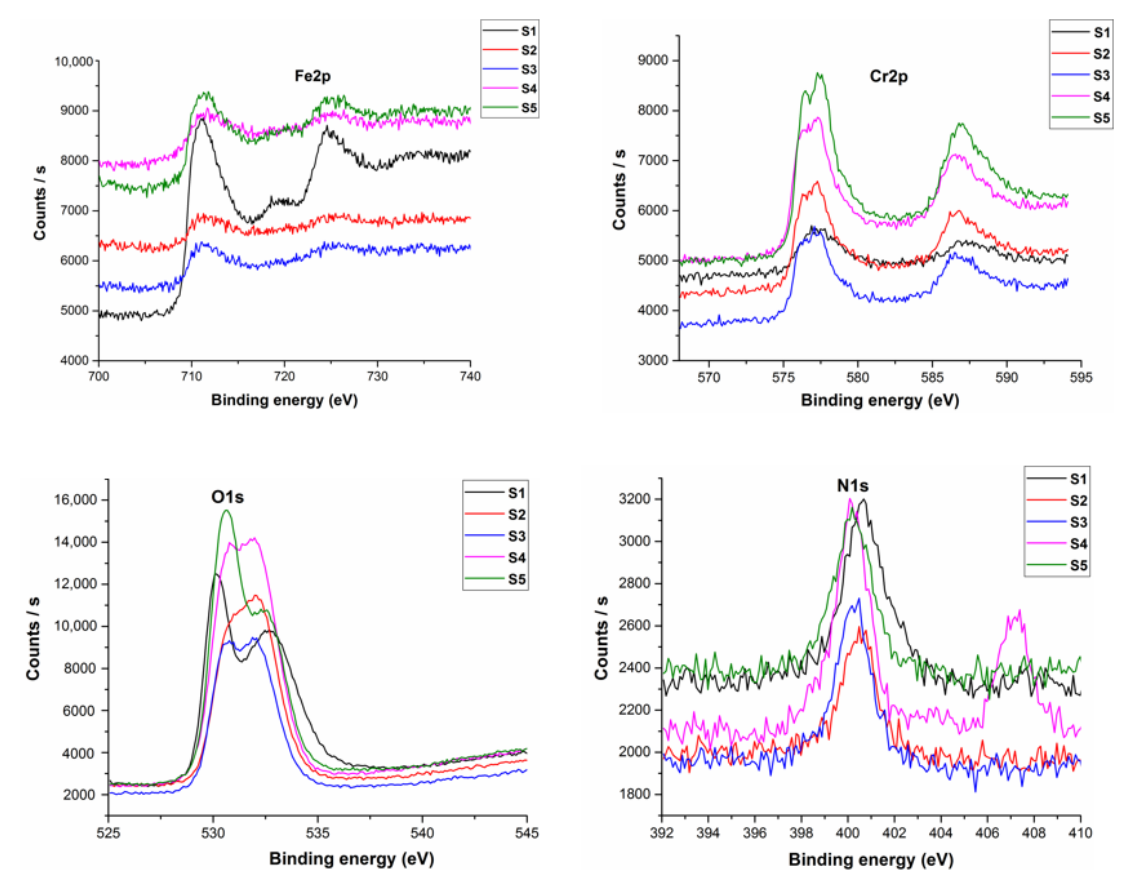
Figure 8. XPS spectra of all specimens.